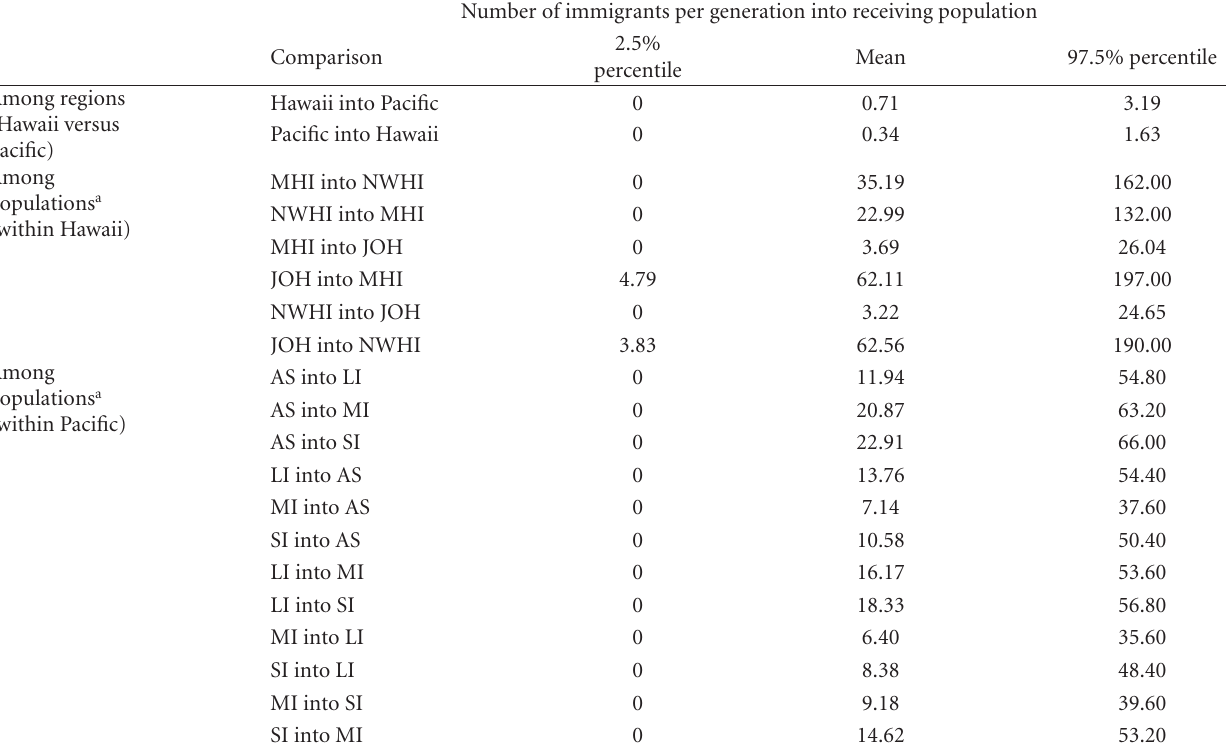
Table 4: Strength and direction of gene flow for Acanthurus nigroris: (1) between the MHI ( N = 92 individuals), NWHI ( N = 278 individuals), and Johnston Atoll ( N = 34 individuals), (2) among all remaining Pacific populations ( N = 98), and (3) between Hawaiian and Pacific populations by pooling all sampled individuals (Hawaii, N = 445; Pacific, N = 99). Values are reported as the mean e ff ective number of migrants ( Nm ) per generation taken from ten independent